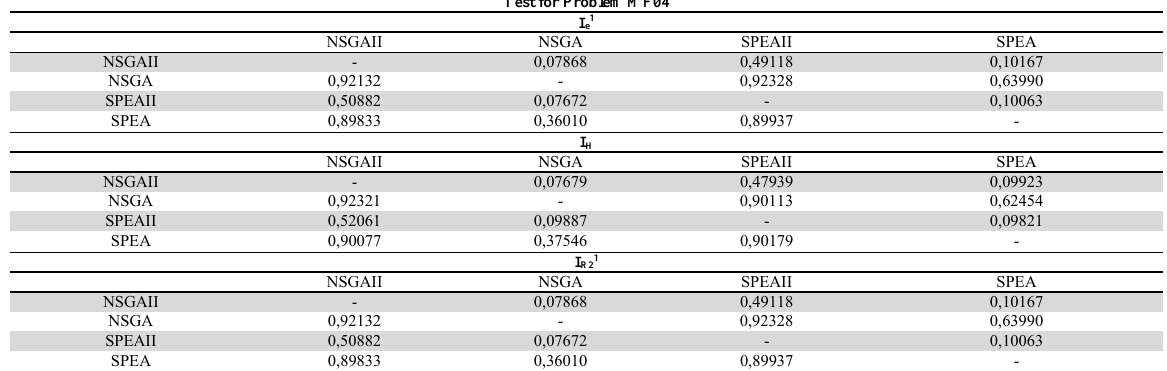
Table 11 Unary epsilon indicator, unary hypervolume indicator and R indicator